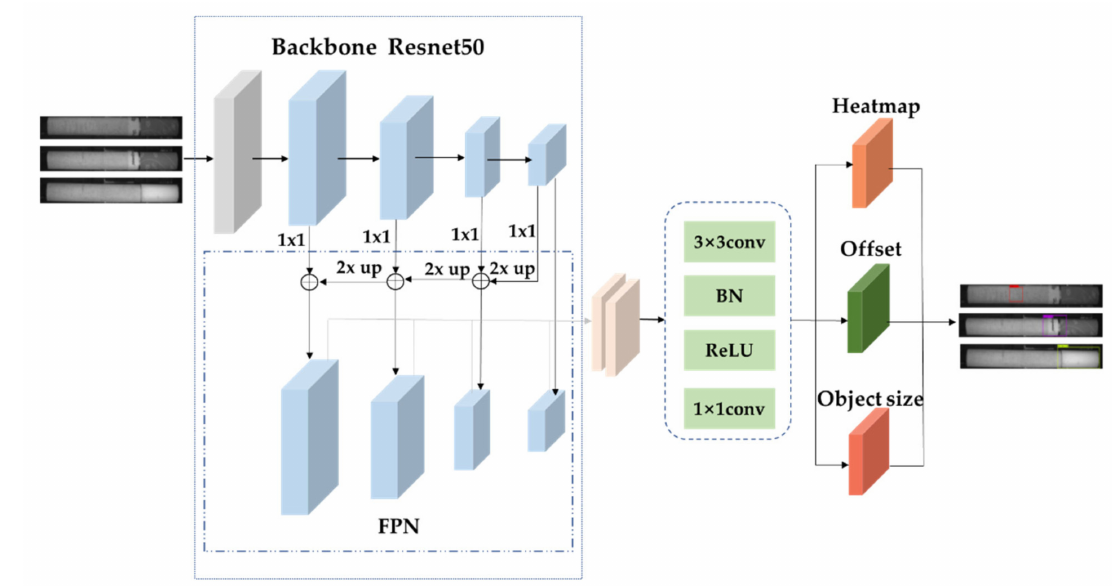
Figure 2. Overall structure of C-CenterNet.